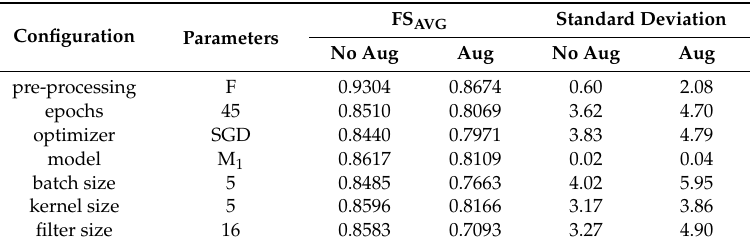
Table 6. The best parameters of CNN.